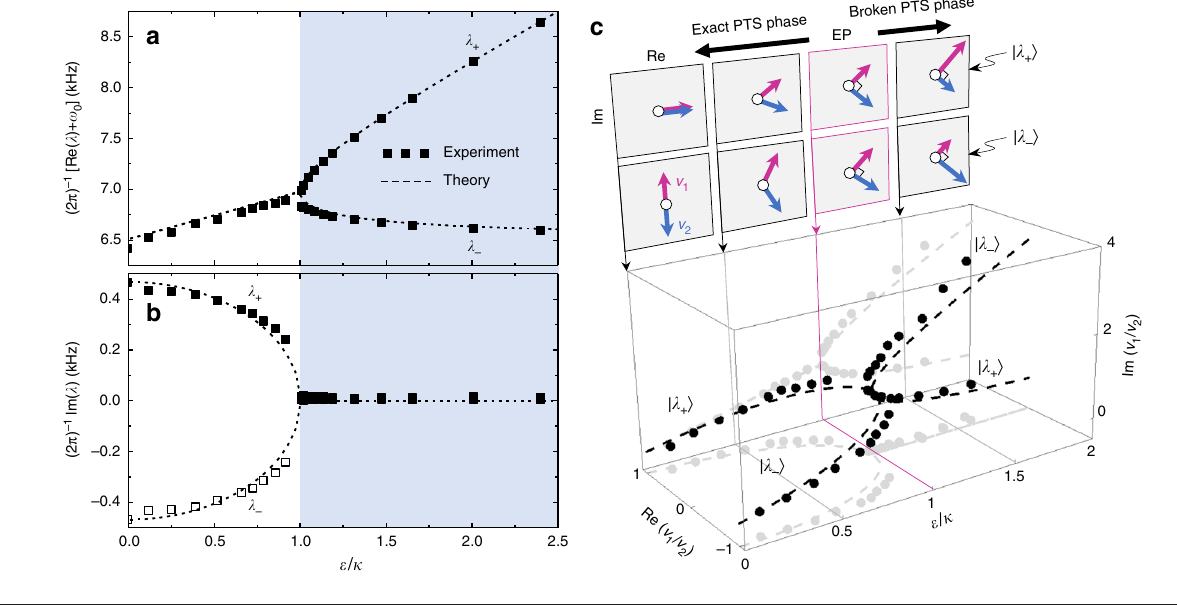
Fig. 3 Eigensystem structure of an APT-symmetric circuit. a , b Real and imaginary eigenvalues inferred from the resonance-excitation spectra in Fig. 2b in comparison with theory. The theoretical curves are obtained by a binary Hamiltonian model derived from Kirchhoff ’ s circuit laws. The shaded area for ε / κ > 1 indicates the parametric region of the broken PT-symmetry (PTS) phase. c State amplitude ratio v 1 / v 2 as a function of the energy-detuning parameter ε , where v n denotes complex amplitude of the state vector | v 〉 such that | v 〉 = [ v 1 v 2 ] T . Circles indicate experimentally obtained values and dashed curves are obtained from the binary Hamiltonian model. The upper inset panels show corresponding eigenvector | λ ± 〉 coordinates on the Gauss plane for ε = 0, 0.5 κ , κ , and 1.5 κ